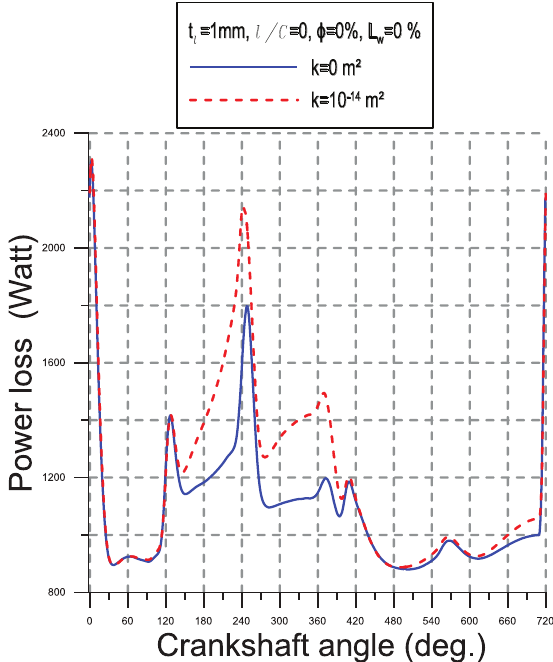
Fig. 25. Effects of bearing-liner permeability parameter on side leakage fl ow over entire cycle.